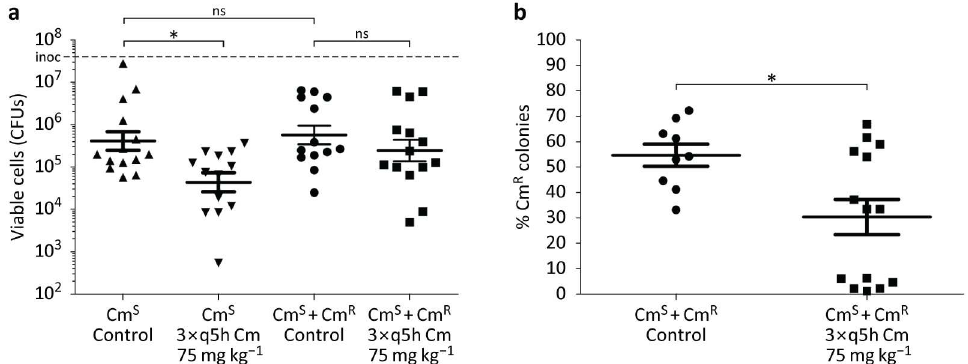
Fig 5. Cross-protection in a mouse pneumonia model. ( a ) Eight-wk-oldfemale CD1 mice were infected intratracheally with Cm S pneumococci or an equivalent amount of Cm S + Cm R pneumococci in a one-to-one ratio. One h post infection, mice were treated with one intraperitoneal injectionof Cm 75 mg kg − 1 followedby two additionaldoses spaced 5 h apart. Control mice receivedan injectionof the vehicle alone. n = 14 for Cm S control; 13 for Cm S Cm-treated; 13 for Cm S + Cm R control; and 14 for Cm S + Cm R Cm-treated. Data plotted as averageand s.e.m. of two independent experiments combined.Dashedline ‘inoc’denotes the initial inoculum. * p < 0 . 05 ;one-wayANOVA with Tukey’s multiple comparison post-test. ( b ) Bacterial coloniesrecoveredfrom the Cm S + Cm R control and Cm S + Cm R Cm-treated mice were individuallypicked and used to inoculateTHY media in 96-wellplates. These 96-wellplates were then used to inoculate96-wellplates with THY media containingeither 15 μ g ml − 1 Cm or 100 μ g ml − 1 kanamycin to determine whether or not the originalbacterial colony was Cm S or Cm R . n = 9 for Cm S + Cm R control and 14 for Cm S + Cm R Cm-treated. Data plotted as averageand s.e.m. of two independent experiments combined. * p = 0.04; Mann–Whitney U test (see S1